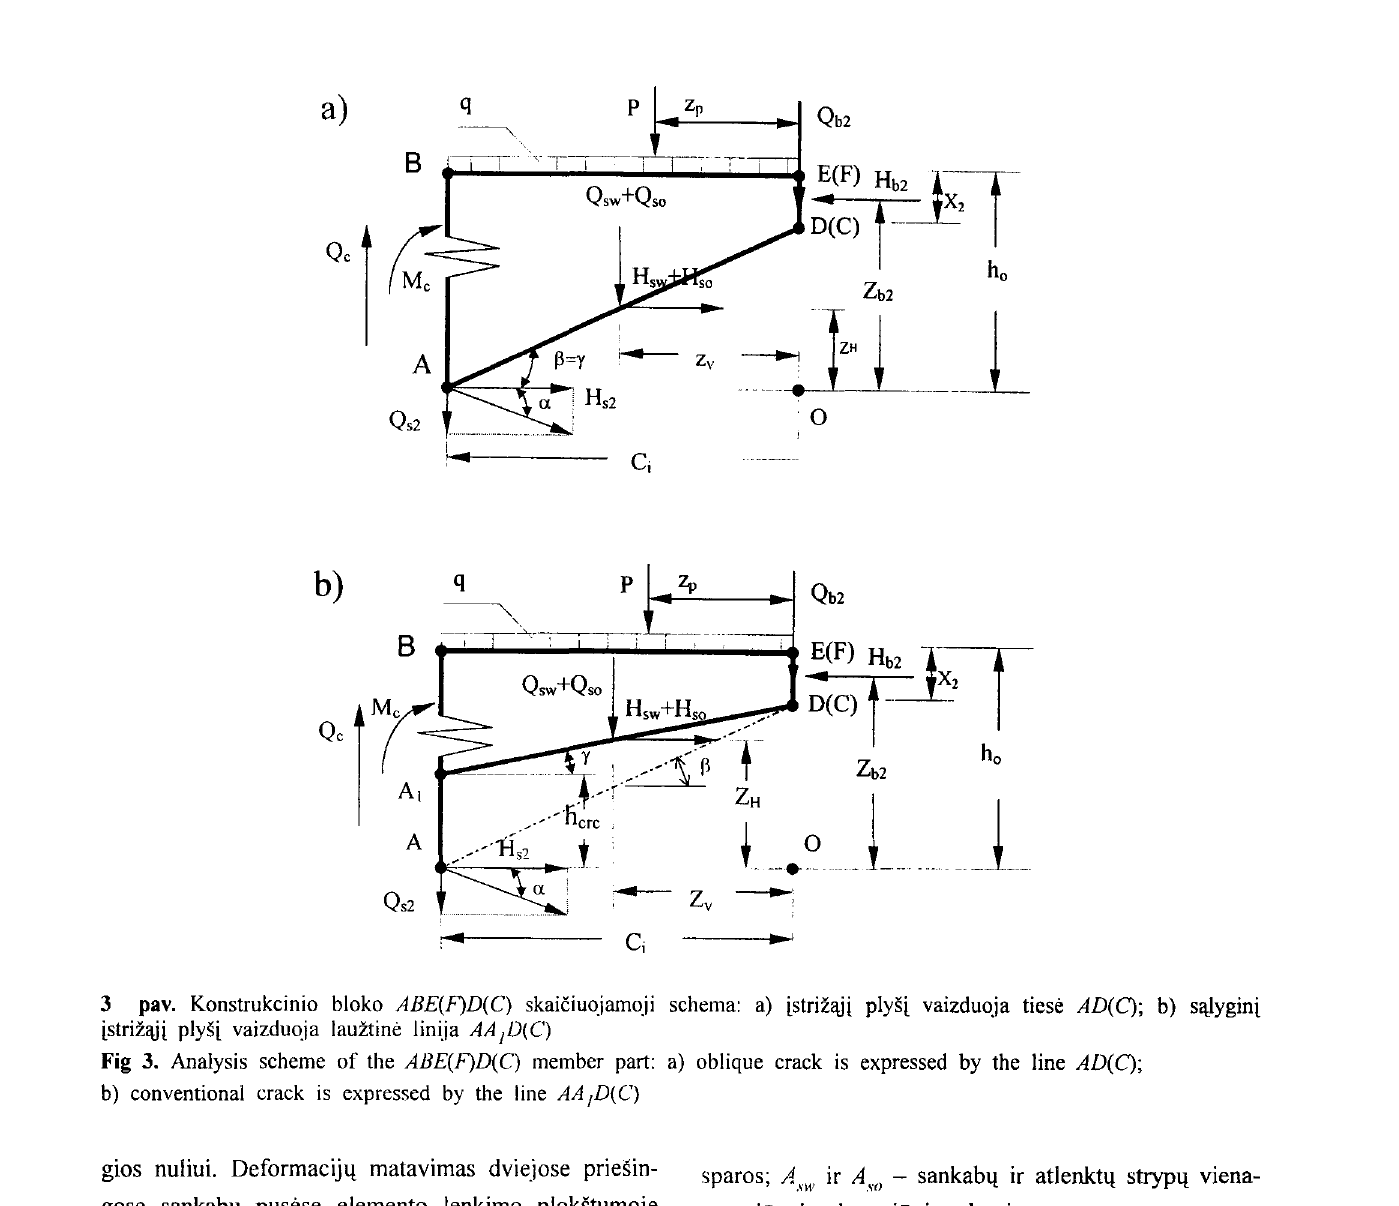
Fig 3. Analysis scheme of the ABE(F)D(C) member part: a) oblique crack is expressed by the line AD(C); b) conventional crack is expressed by the line AA gios nuliui. Deformacijq matavimas dviejose priesin gose sankabq pusese elemento lenkimo plokstumoje taip pat yra nevienodos. Taigi skersine armatiira